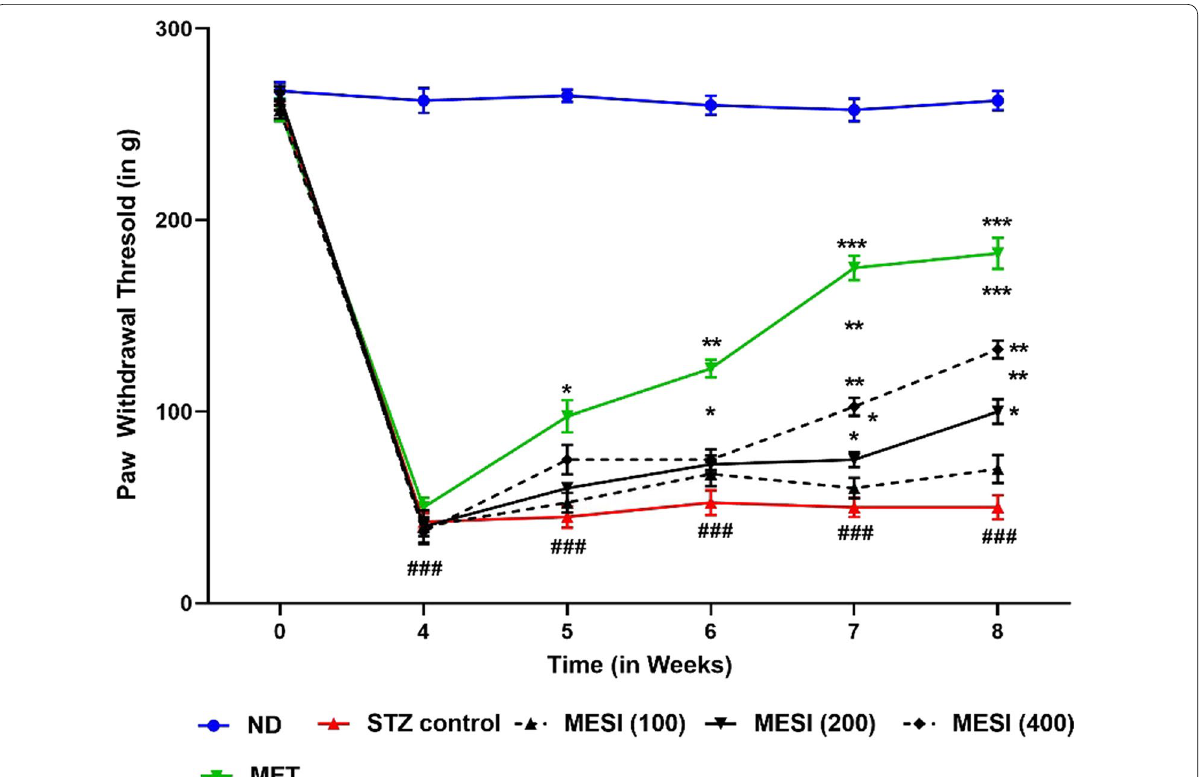
Fig. 1 Effect of chronic treatment of MESI and metformin on diabetes-induced mechanical hyperalgesia in Randall–Selitto paw pressure test. Data are expressed as mean SEM ( n 6) and analyzed by two-way ANOVA followed by Bonferroni’s multiple range post hoc test. *P < 0.05 and ± = **P < 0.01for MESI, and *** P < 0.001 for metformin-treated groups compared to the diabetic (STZ) control group. ### P < 0.001 for the diabetic (STZ) control group compared to the normal non-diabetic